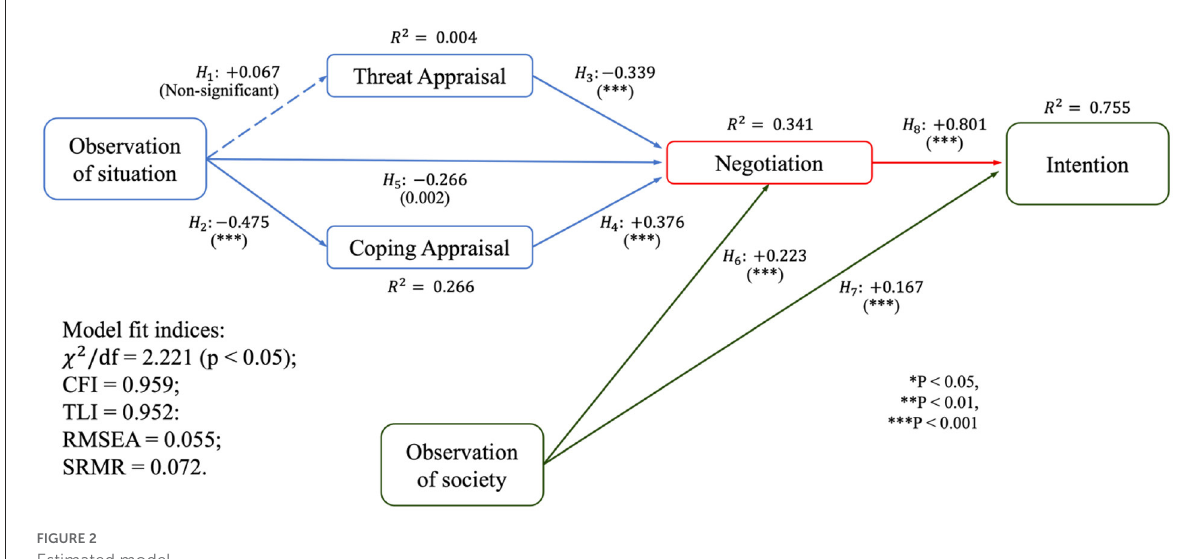
FIGURE2 Estimated